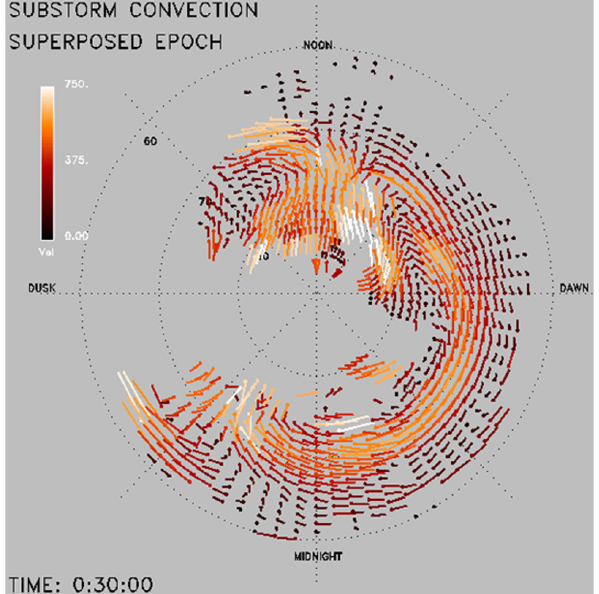
Fig. 14. The flow of electrons during a substorm. The eastward flow represents the westward electrojet (Bristow and Jensen, 2007).